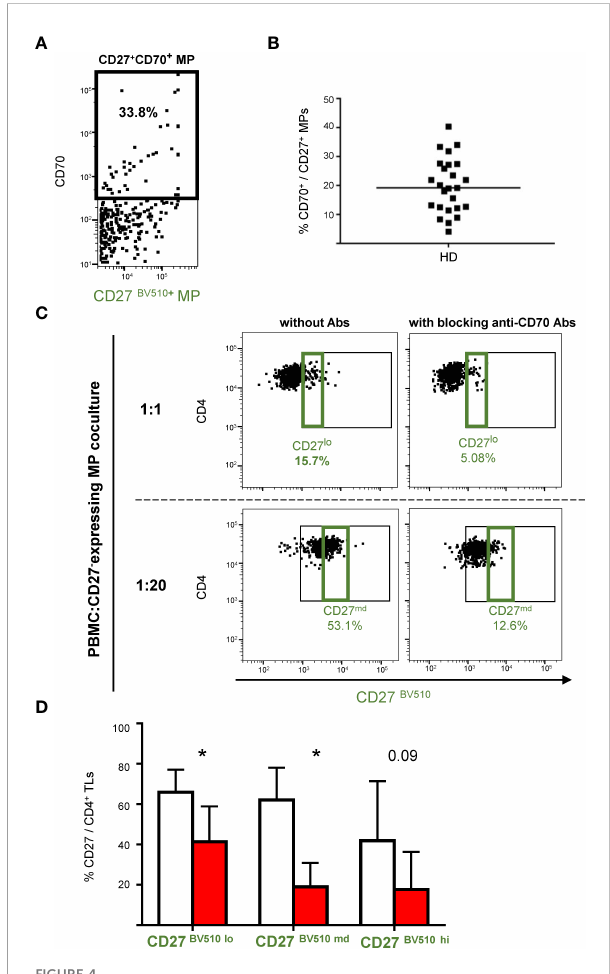
FIGURE 4 CD27 + MP binding to CD4 + T cells after coculture with CD27/CD70- labeled MPs. (A) Example of the gating used for phenotyping CD27 + MPs from one HD for the CD70 receptor. Only MPs expressing CD27 are represented on this plot. Phenotyping was performed on MPs stained with a anti-CD27-BV510 antibody from 25 HDs in two experiments. (B) Percentage of CD27 + MPs expressing CD70. The horizontal bar indicates the median. (C) Example of the gating strategy used to highlight the expression of CD27 from MPs on the surface of CD4 + TLs (PBMCs were stained with anti-CD4 and anti-CD3 antibodies; CD4 + TLs were de fi ned as having a CD3 + CD4 + phenotype; only CD4 + TLs are presented), in the presence and absence of blocking anti-CD70 antibody. PBMCs were cocultured for 18 hours with known numbers of CD27-expressing MPs at ratios of 1:1, 1:10 and 1:20 (PBMCs: CD27-expressing MPs). Cocultures were assessed for seven HDs in four experiments. (D) Percentage of CD4 + TLs expressing CD27 + from MPs at different coculture ratios (PBMCs: CD27-expressing MPs) in the presence and absence of blocking anti-CD70 antibody. The percentage of CD4 + CD27 lo TLs was determined for the 1:1 ratio (PBMCs: CD27-expressing MPs); the percentage of CD4 + CD27 md TLs was determined for the 1:10 ratio, and the percentage of CD4 + CD27 hi TLs was determined for the 1:20 ratio, with ( ■ ) and without ( □ ) blocking anti-CD70 antibody. The P values presented were obtained in t tests: * P <